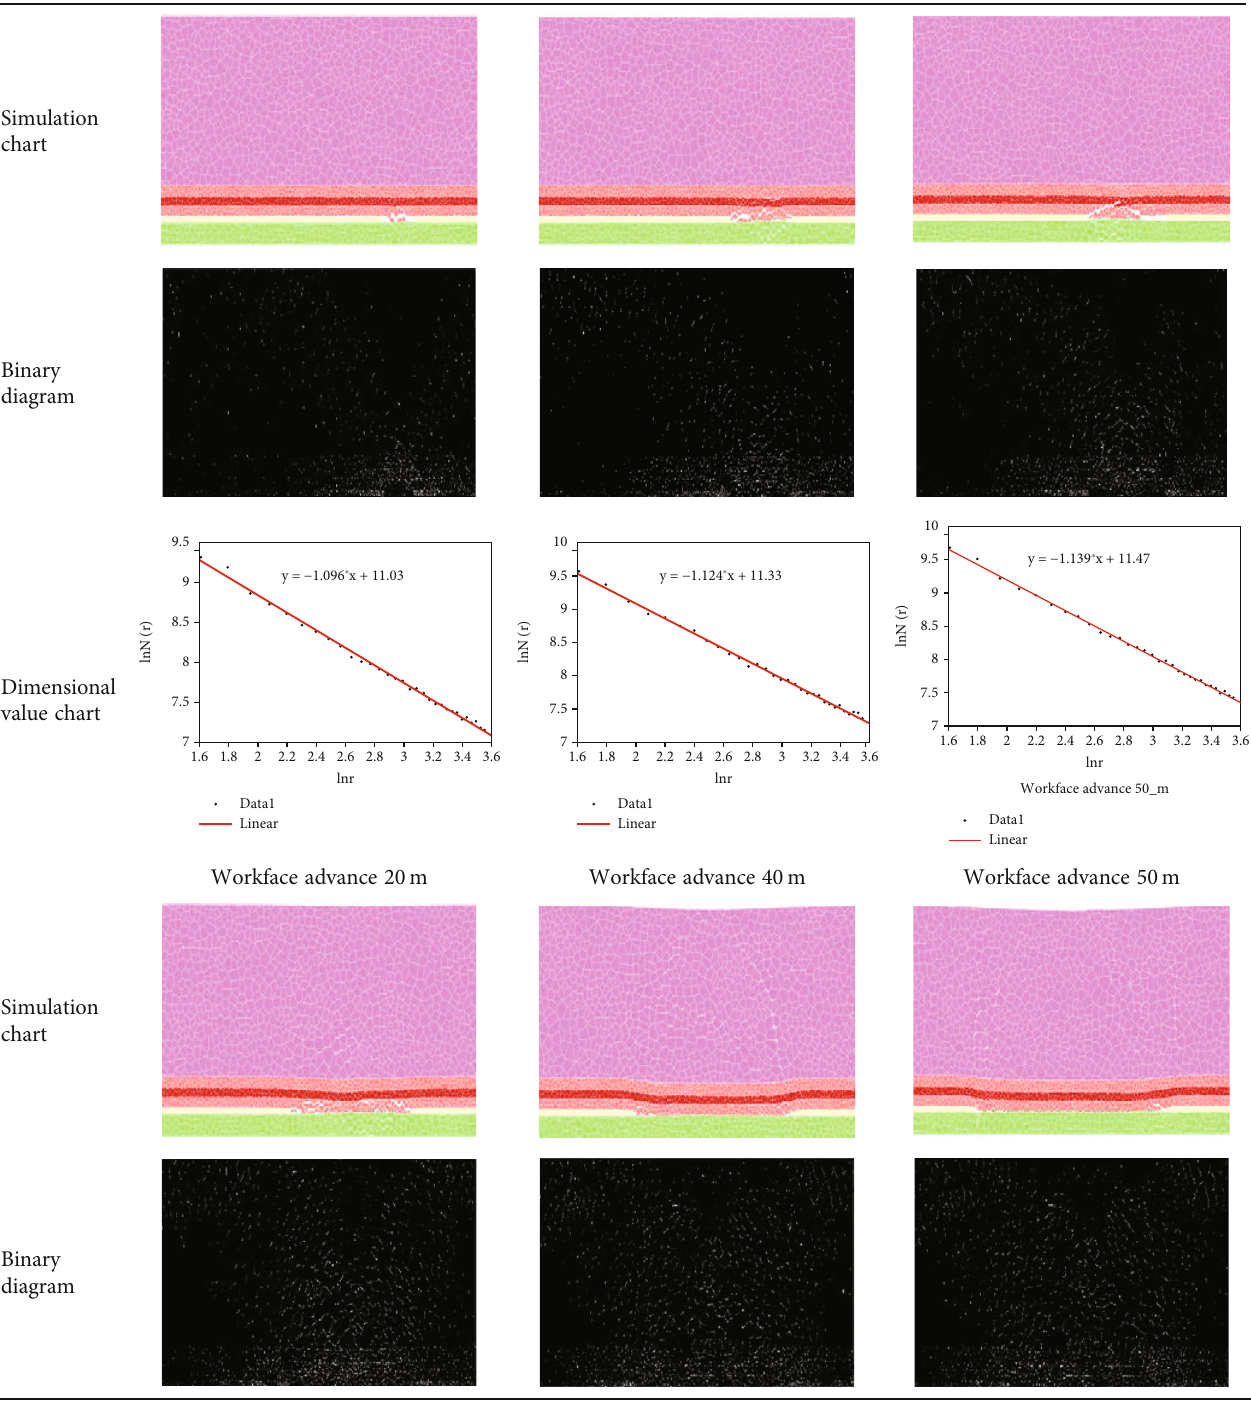
Table 2: Numerical simulation diagram, binary diagram, and fractional dimensional diagram associated with di ff erent working face